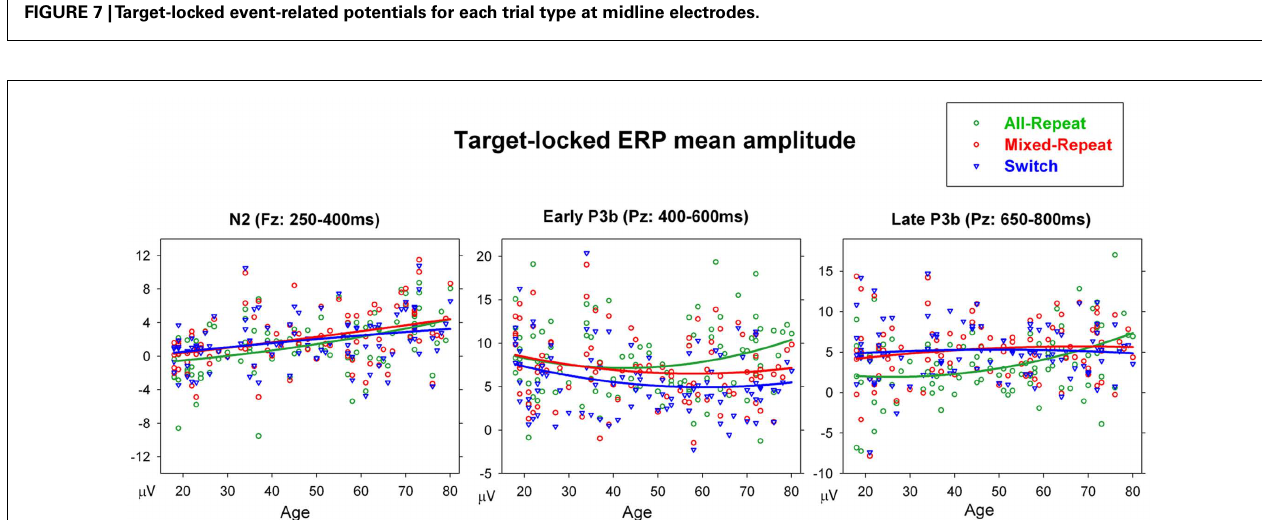
FIGURE 8 | Scatterplots of age against mean amplitude for frontal N2 at Fz, early and late P3b (at Pz) for each trial type in target-locked ERPs.